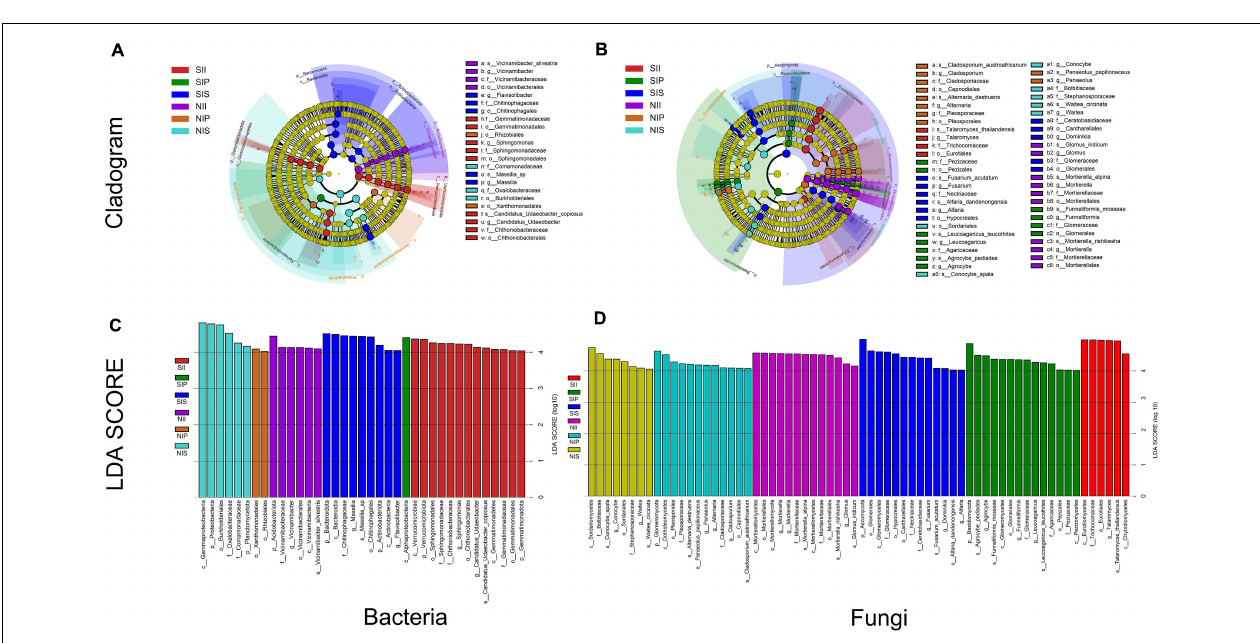
FIGURE 7 | Linear discriminant analysis effect size of the peanut rhizosphere (IP), sorghum rhizosphere (IS), and interspecific interaction zone (II) microbial biomarkers under different soil conditions (S, 0.25% salt-treated soil condition; N, normal soil condition). (A) Bacterial core community composition. (B) Fungal core community composition. (C) LDA scores of biomarker bacteria. (D) LDA scores of biomarker